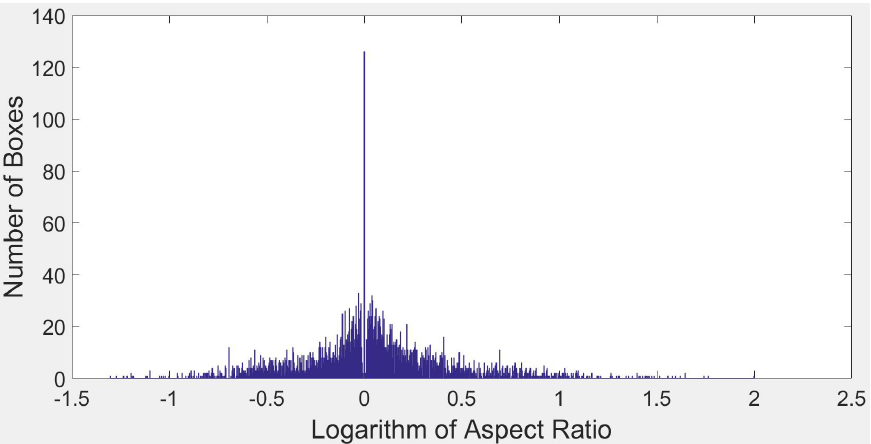
Figure 4. Aspect ratio of training annotations.